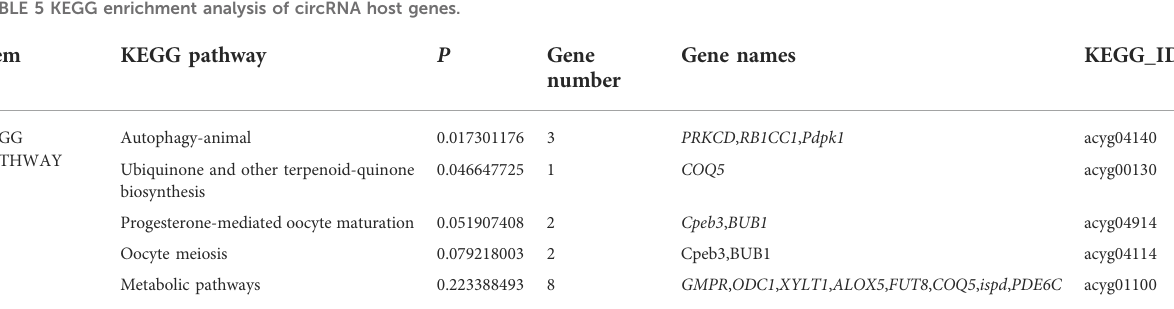
TABLE 5 KEGG enrichment analysis of circRNA host